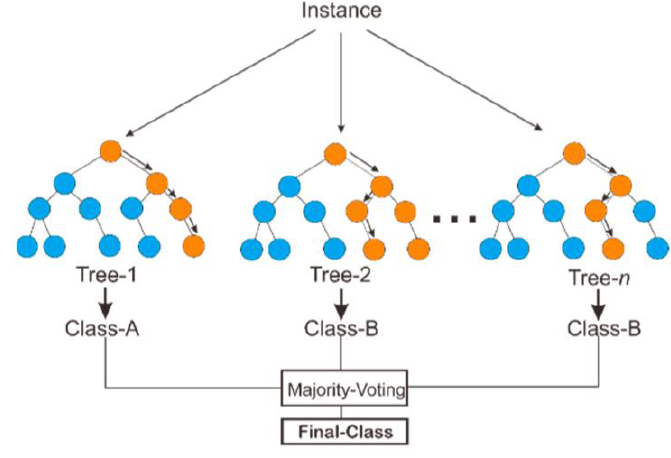
Figure 3. RF Structure [36].